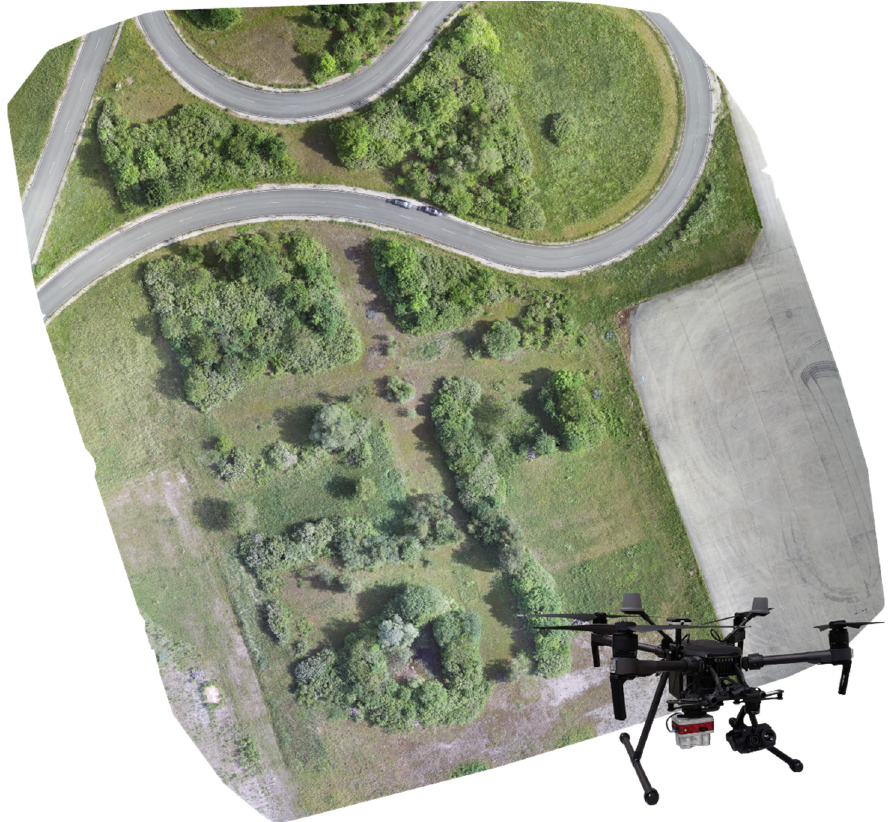
Figure 2. The visual orthophoto that was used to generate the visual bands of MUCAD. The setup utilized for taking the raw images was composed of a DJI Zenmuse XT2 and a MicaSense Altum mounted on a Matrice 210 RTK V2. Table 1. Characteristics and associated sensor of each band.